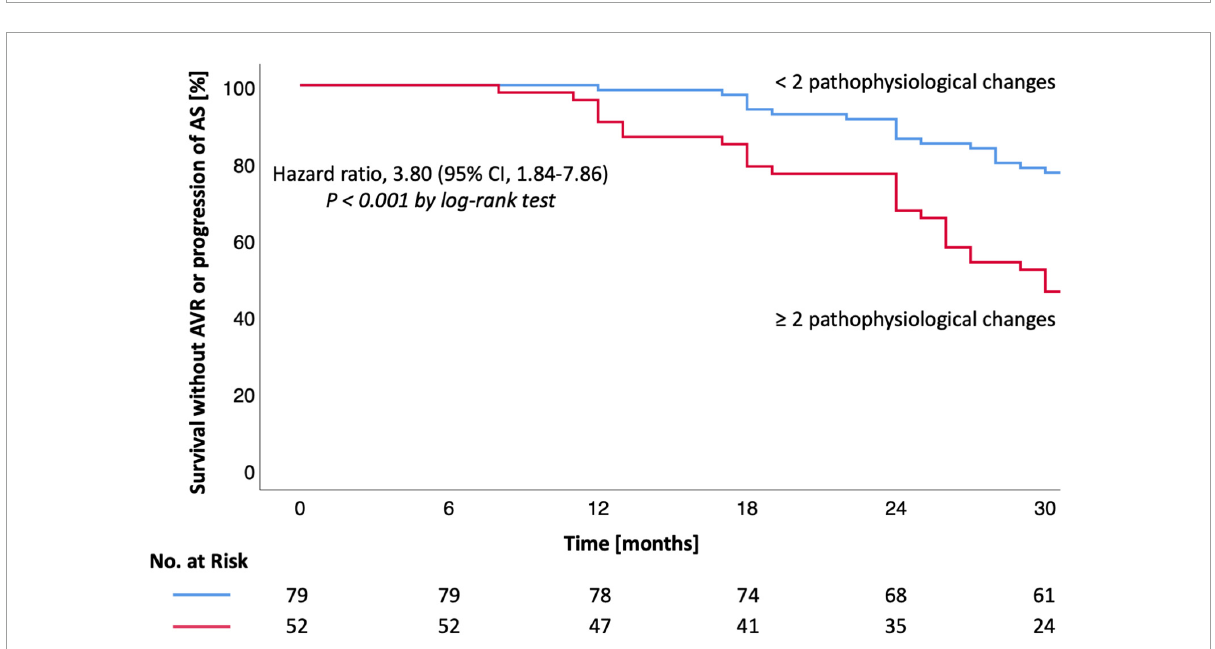
FIGURE2 Kaplan-Meier estimates for survival without AVR or AS progression in moderate AS. Kaplan-Meier estimates are shown for the secondary outcome (survival without AVR or AS progression). CI denotes confidence interval. Hazard ratio and CI were calculated by cox proportional-hazards model (log-rank test). A P -value < 0.05 was considered to indicate statistical significance. AS, aortic valve stenosis; AVR, aortic valve